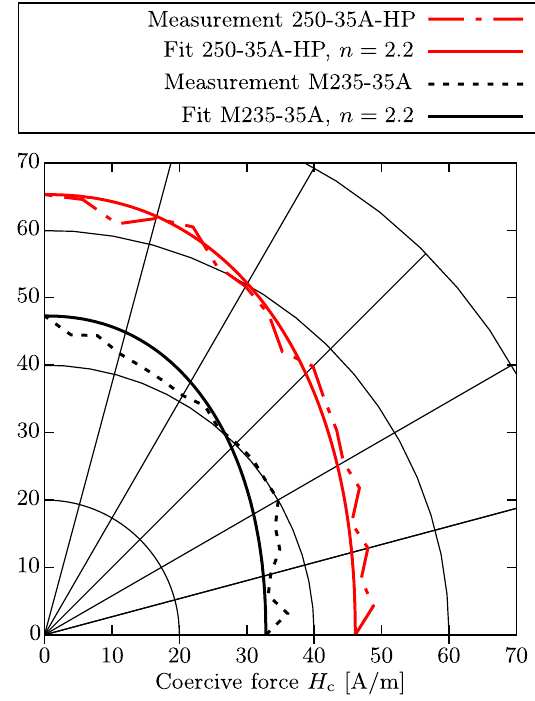
FIG. 18. Measurement and fit of the coercive force versus angle in polar coordinates at J ≈ 1 . 6 T for two NGO steel grades.